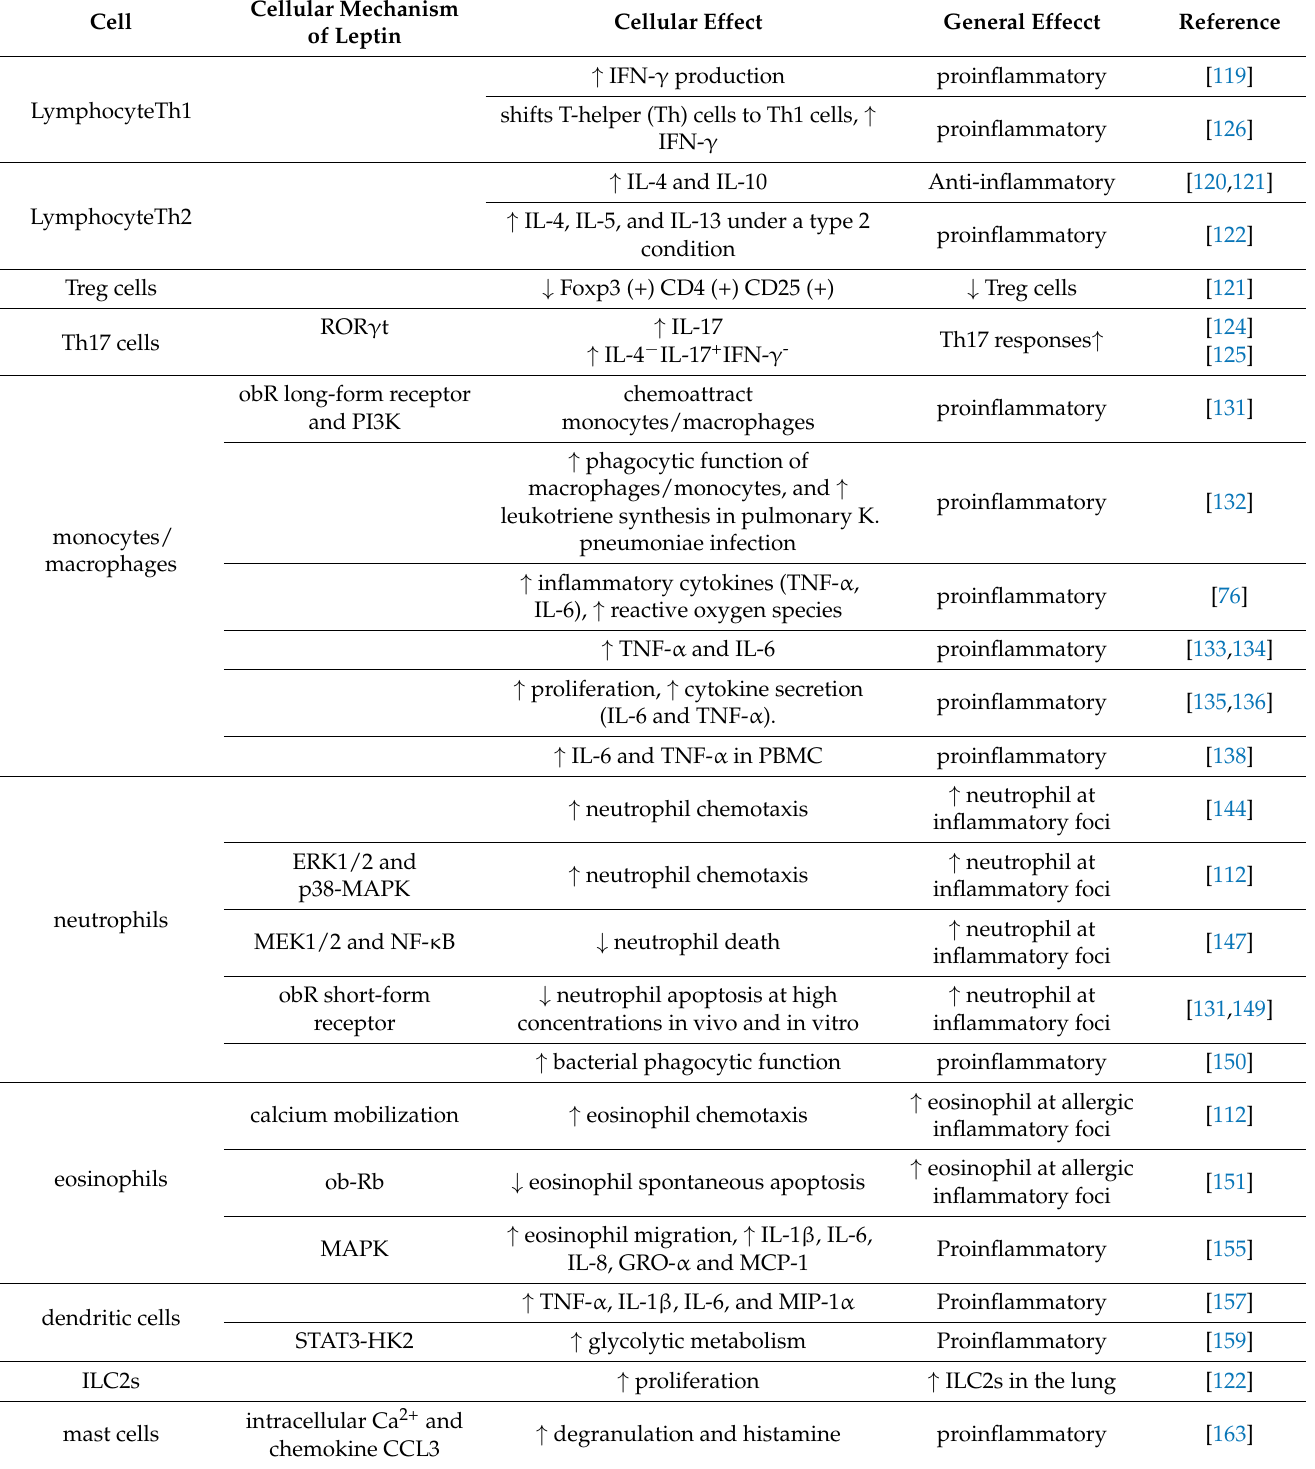
Table 2. Cellular mechanisms of leptin in immune responses, ↑ = increased level; ↓ = decreased